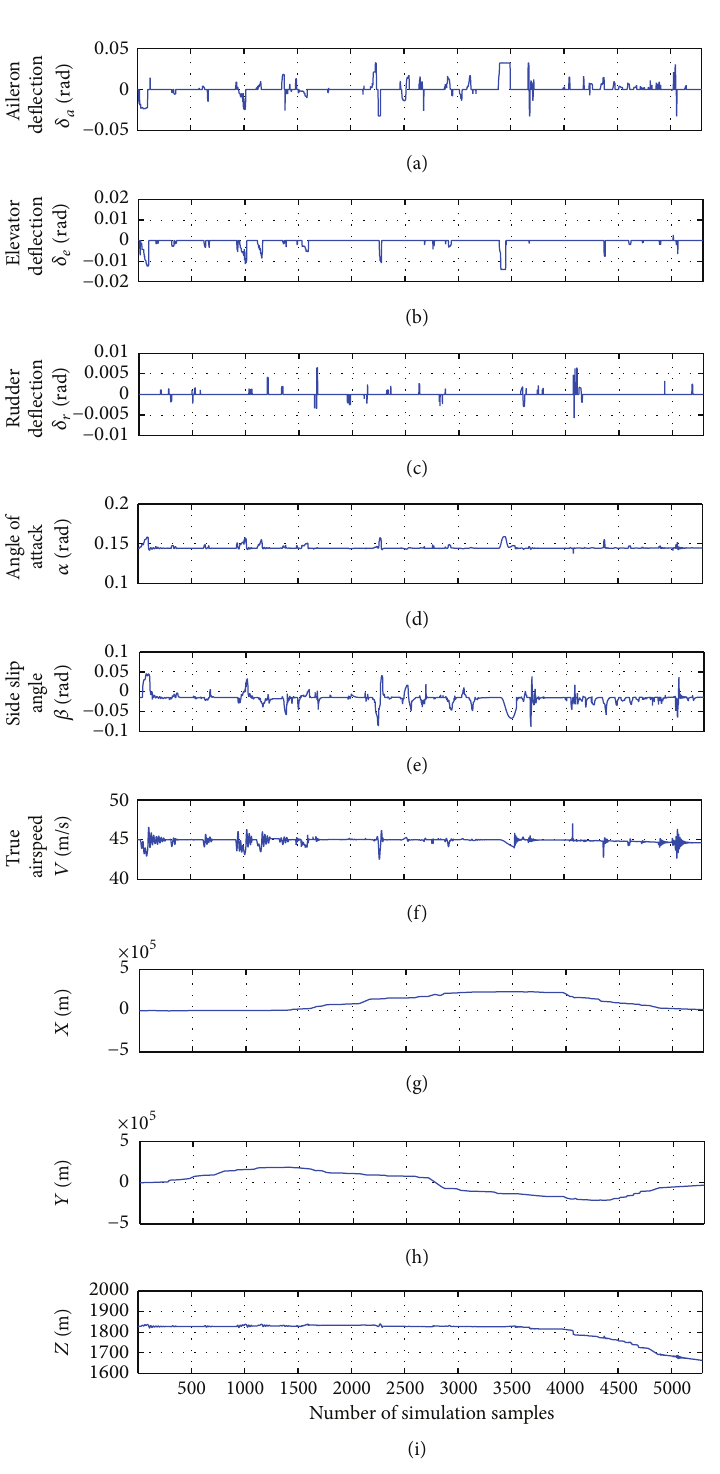
Figure 11: Simulated mission signals playback.